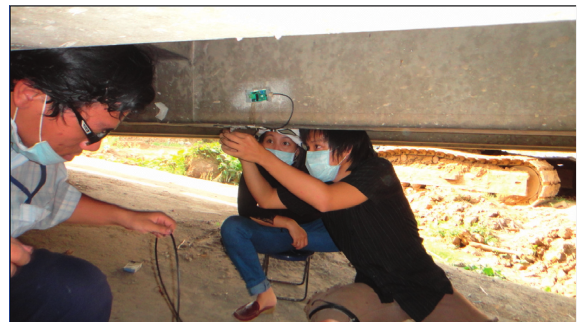
Figure 9: Practical measuring deformation